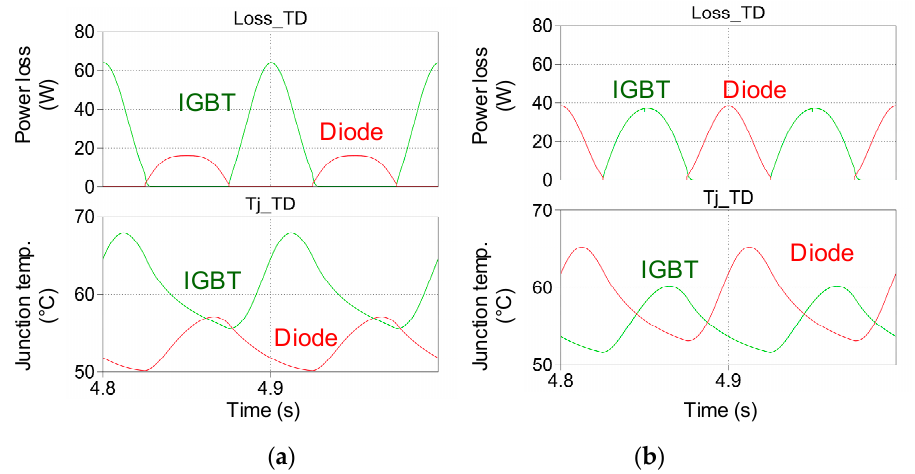
Figure 9. Loss dissipation and junction temperature of IGBT and diode with fundamental frequency of